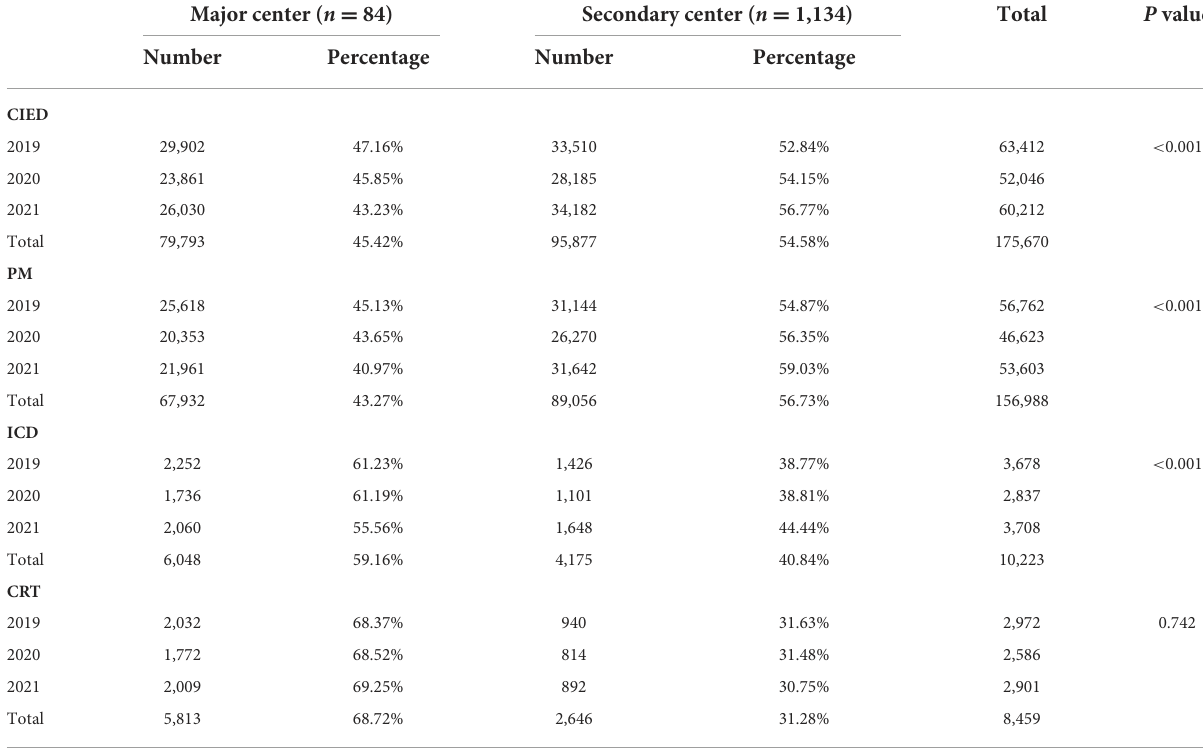
TABLE 2 Changes in CIED implantation in major and secondary centers from 2019 to